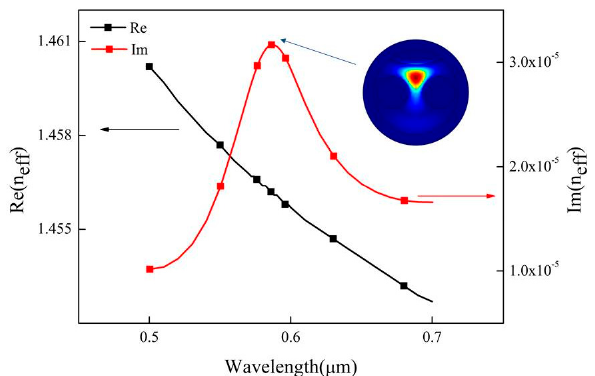
Figure 2. The real and imaginary parts of the effective refractive index of the fundamental mode change with wavelength. Conditions: n = 1.33.